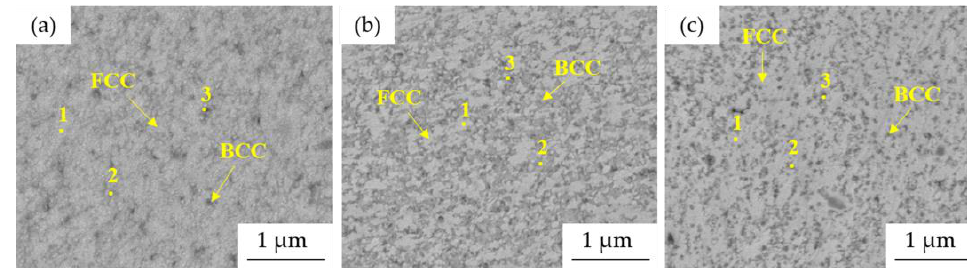
Figure 4. SEM micrographs and points of EDS analysis of MA powder alloys: ( a ) Mn15Al5, ( b ) Mn10Al10, ( c ) Mn5Al15 (BSE + SE, MAG: 50.0 kx, BI: 11.00, WD 9.00 mm).